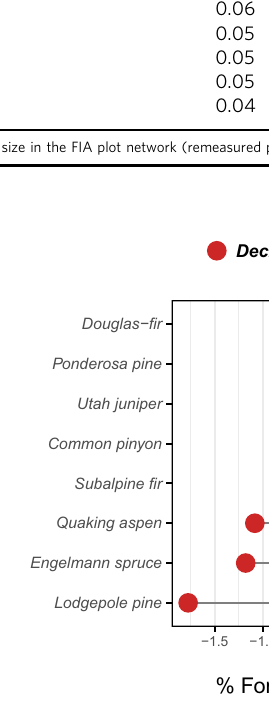
Fig. 2 Range-average % forest stability index (FSI) of the eight most abundant tree species in the western US over the period 2001 – 2018. 95% con fi dence interval does not include zero. Conversely, population